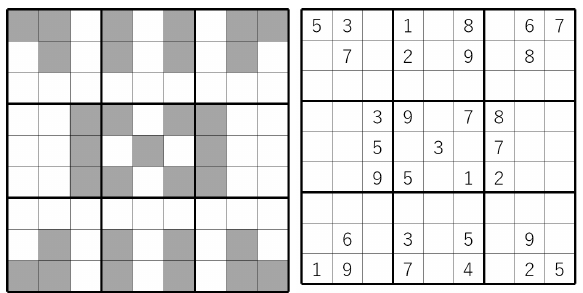
Figure 2. Clue positions ( left ) and clues solvable with naked singles only ( right